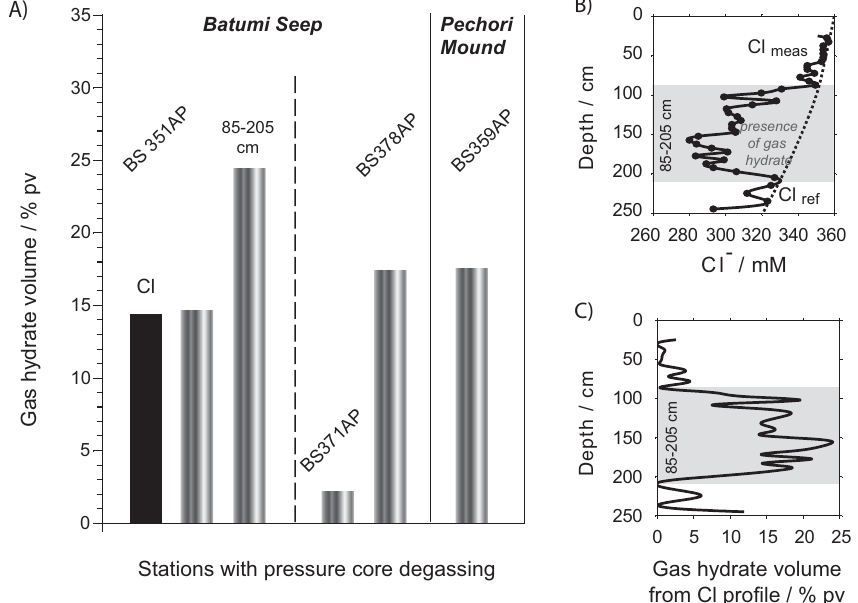
Fig. 2. (a) Gas hydrate volumes in shallow sediments of Batumi Seep and Pechori Mound as calculated from the degassing of the DAPC cores, given in per cent pore volume (%pv). Hydrate volumes for core BS351AP are derived from the degassing (gray columns, gas), the Cl − profile model in (b) and (c) (black column, Cl), and the volume (black column, comb) gained from the combined results of degassing and the chloride measurements, i.e. 211lCH 4 locked in gas hydrates at core depth between 85 and 205cm. (b) Measured Cl − concentrations of BS351AP (dots) in comparison to the modeled “in-situ” Cl − profile (Cl ref , dotted line) characterized by the advection of less saline fluids. (c) Calculated gas hydrate distribution depth as calculated from Cl − anomalies and Cl ref in core BS351AP. Sulfate depletion in core with BS351AP is reached at 75cm core depth. See Methods 3.3 and Appendix for details on the